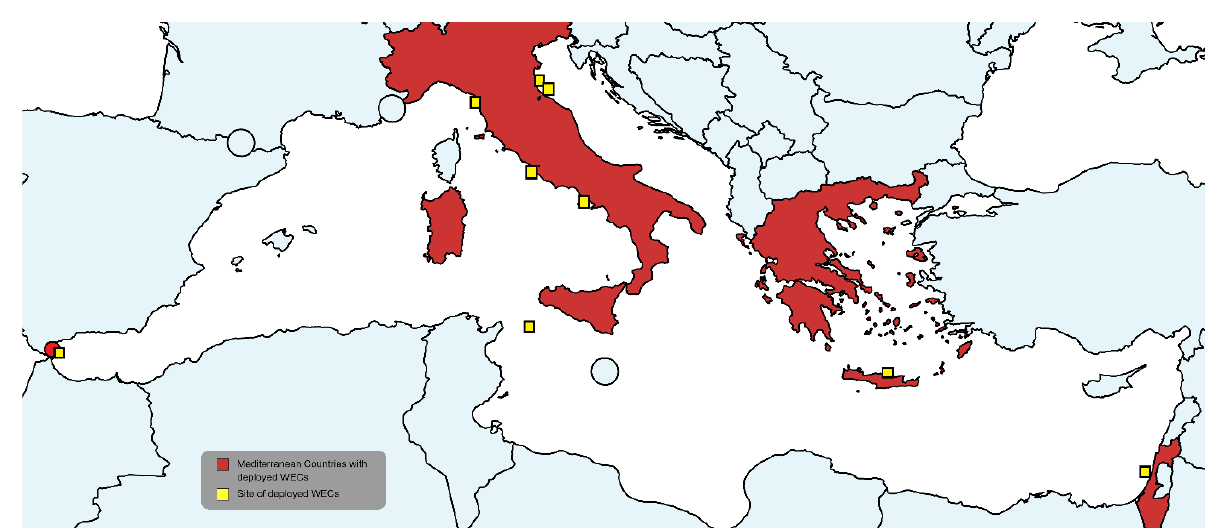
Figure 1. Mediterranean map with the deployed sites of wave energy converters (WECs) (developed on https://mapchart.net/, accessed on 7 June 2021).